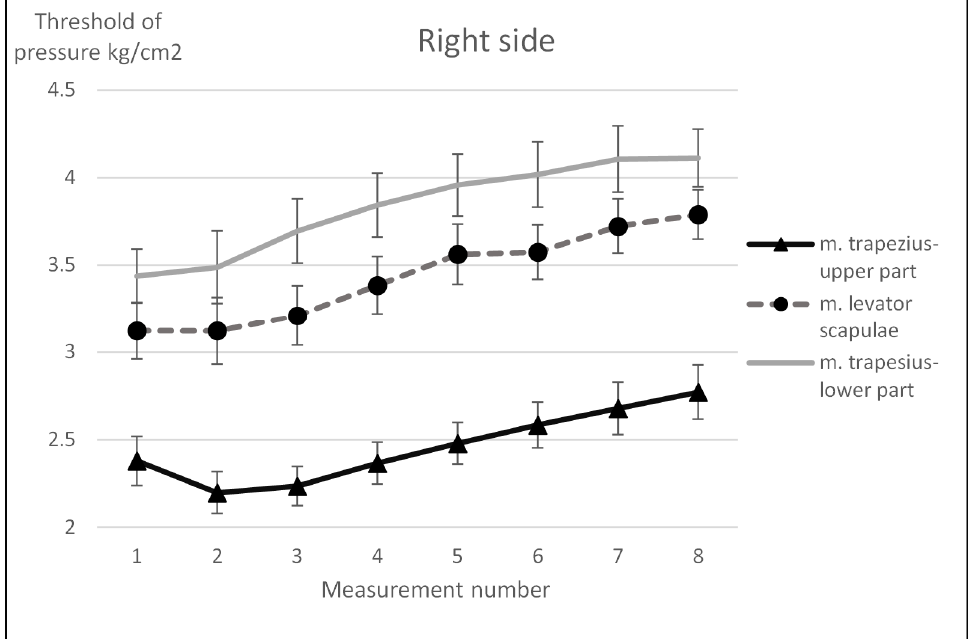
Figure 3. Changes in pain sensitivity of the examined muscle trigger points on the right side (Mean, SE).